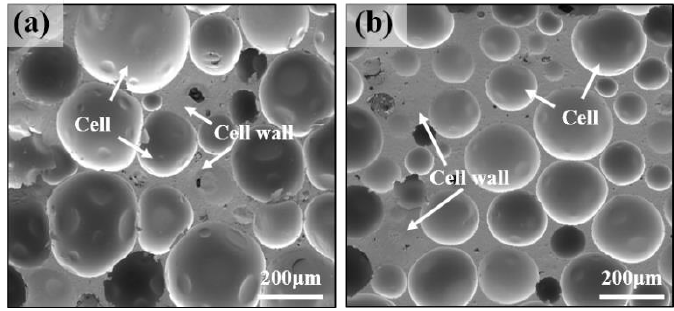
Figure 1. Microstructure of artificial bone ( a ) grade 10 and ( b ) grade 20 via SEM.